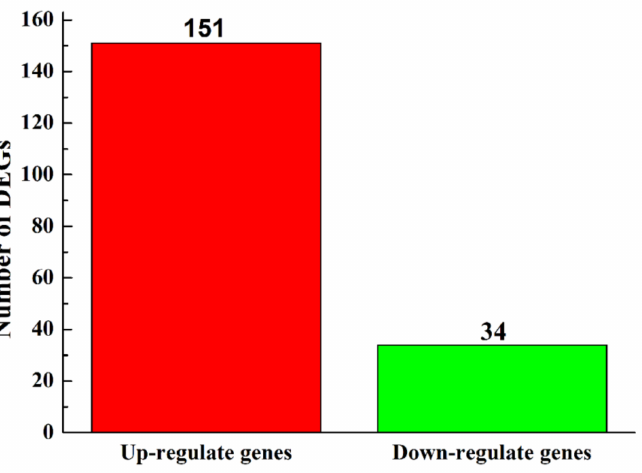
Figure 4. DEGs analysis of A. flavus antagonized by B2 compared to no